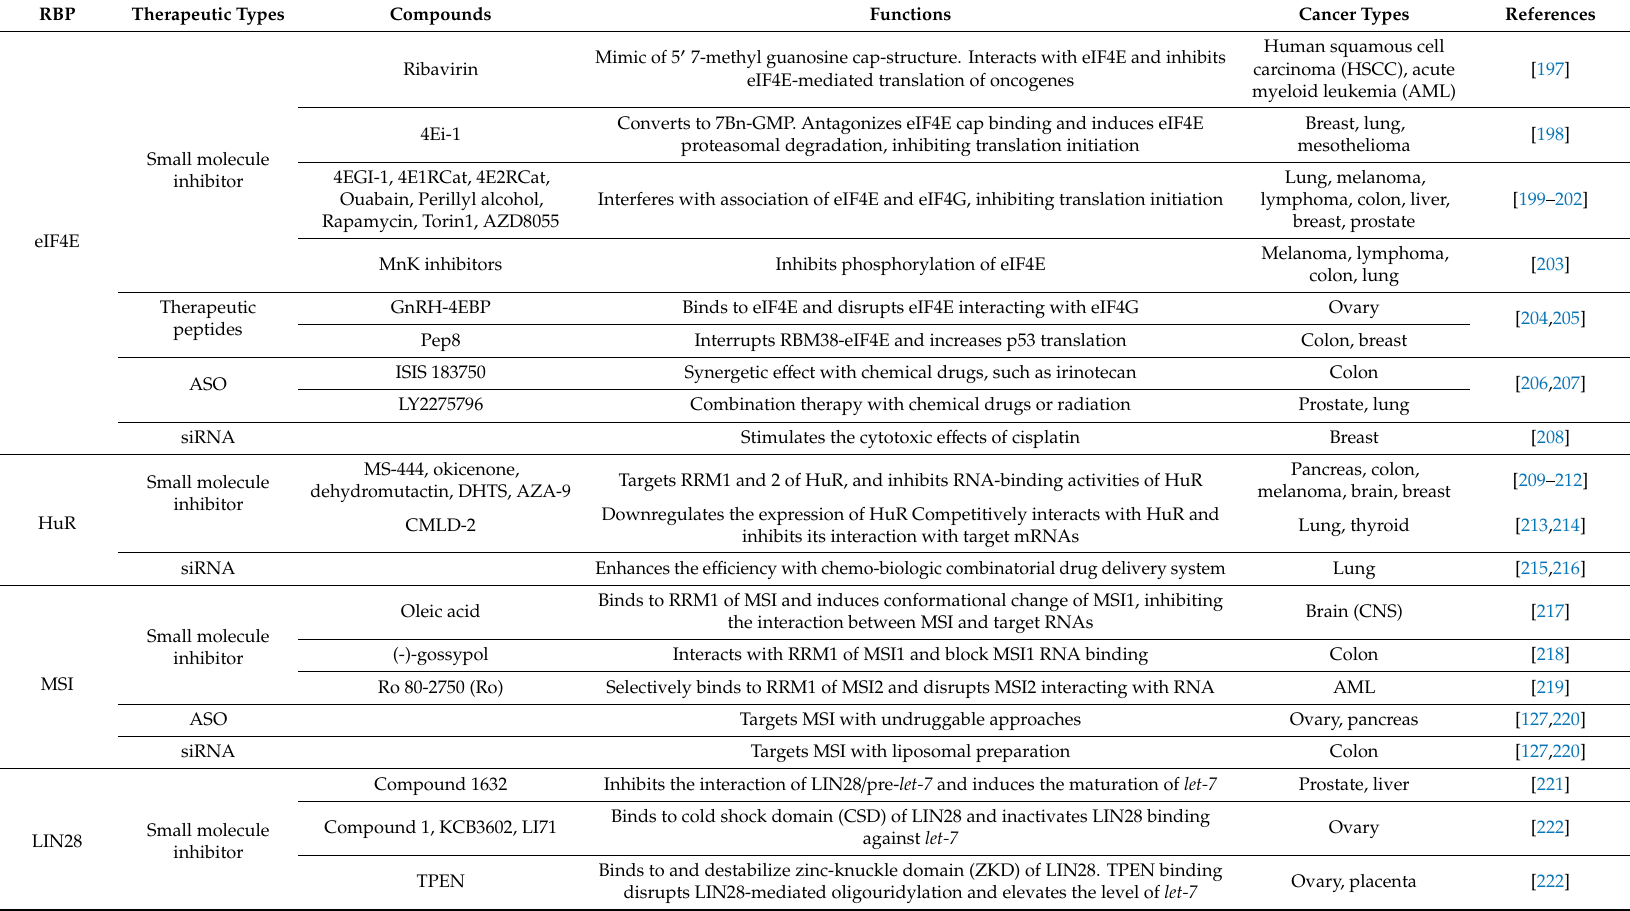
Table 2. Therapeutic strategies of RNA binding proteins (RBPs) in